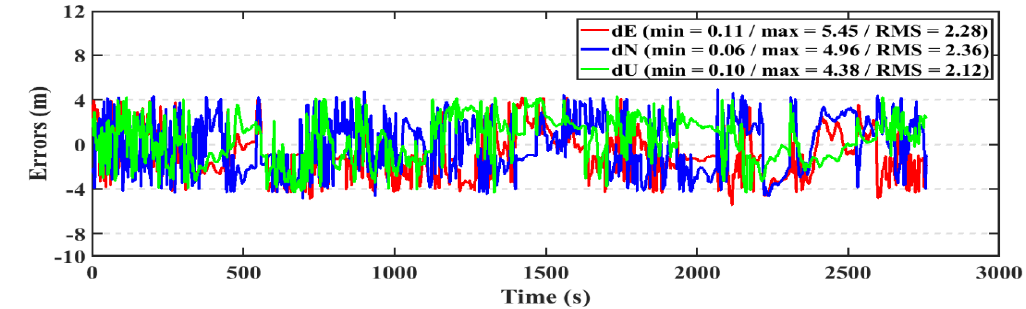
Figure 21. Position errors for the RT-PPP solution (kinematic / first dataset).